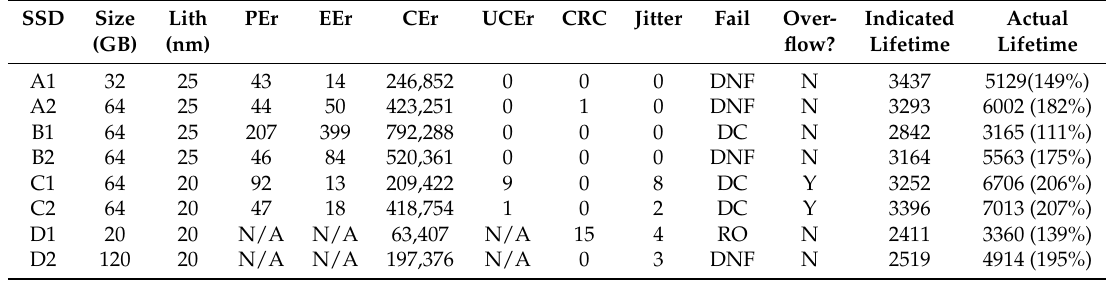
Table 5. Overall results of endurance testing. Lith : Lithography; PEr : Program Error count; EEr :